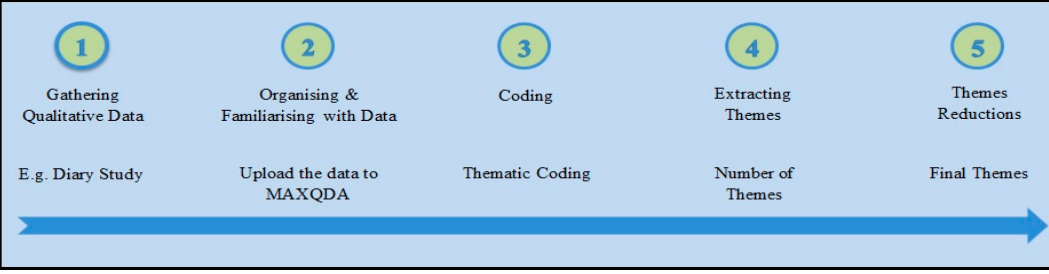
Figure A1. Coding stages.